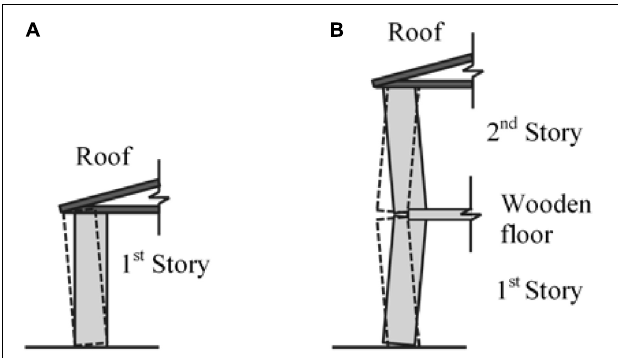
FIGURE 5 | (A,B) Assumed configuration for 1- and 2-story adobe buildings,